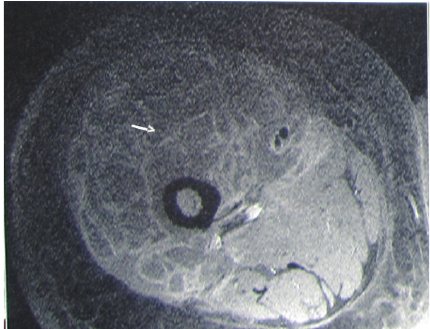
Figure 2: MRI right thigh—MRI axial T1W image—showing a multiseptated intramuscular abscess with debris in quadriceps